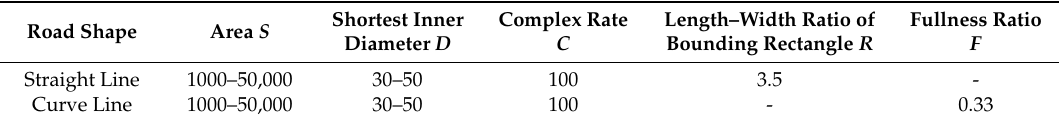
Table 2. Shape-feature threshold setting for road